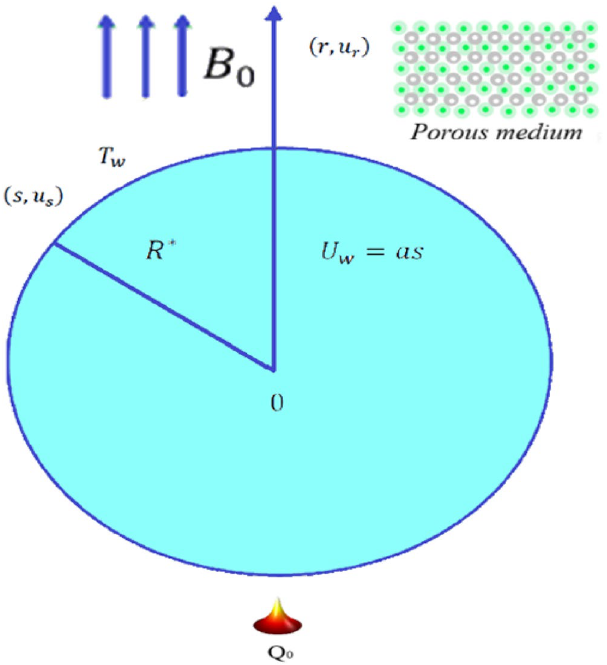
Figure 1. Physical representation with coordinate system.